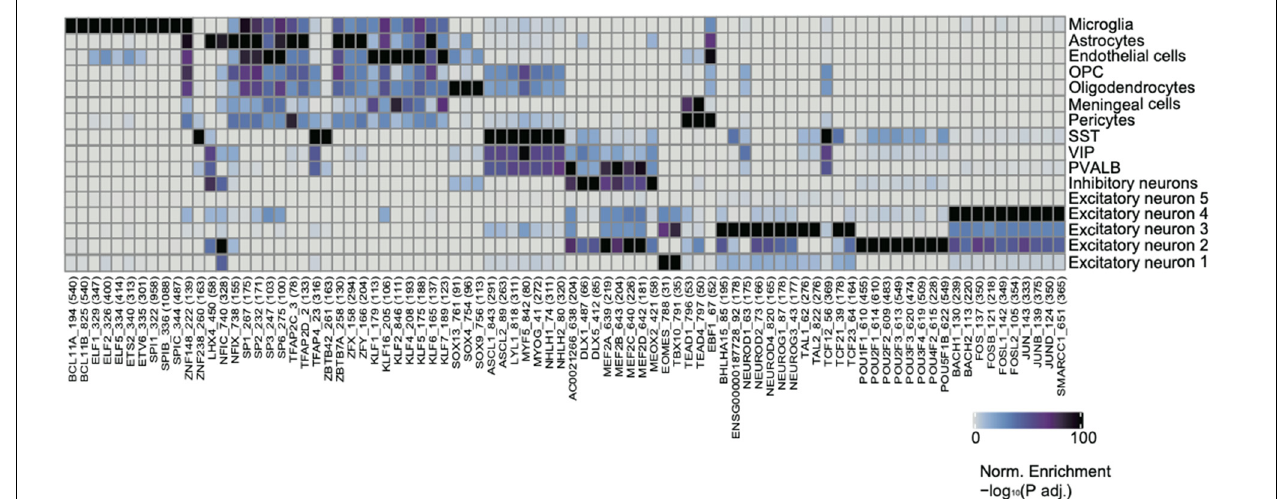
FIGURE 4 | Identification of cell-type-specific chromatin transcription factors (TFs). Heatmap clustering showing the cell-type-specific TFs.